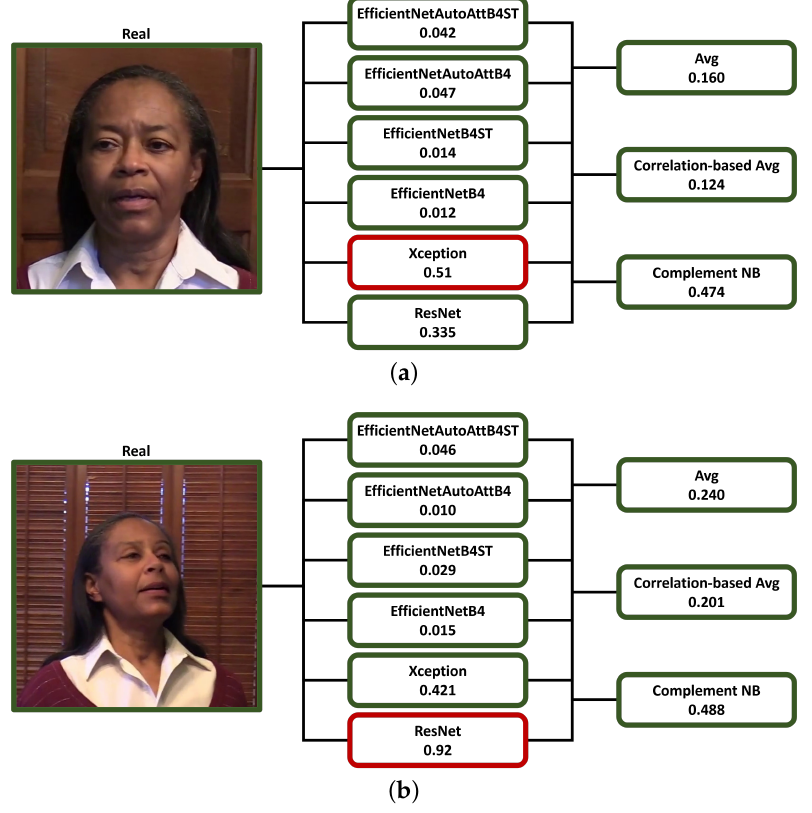
Figure 9. Example of inferences from real images of the DFDC dataset (22093_5 ( a ) and 21309_6 ( b )) of three of the analyzed score-level fusion methods from the scores of the single classification models (scores greater than or equal to 0.5 are identified by a red border and by a green border